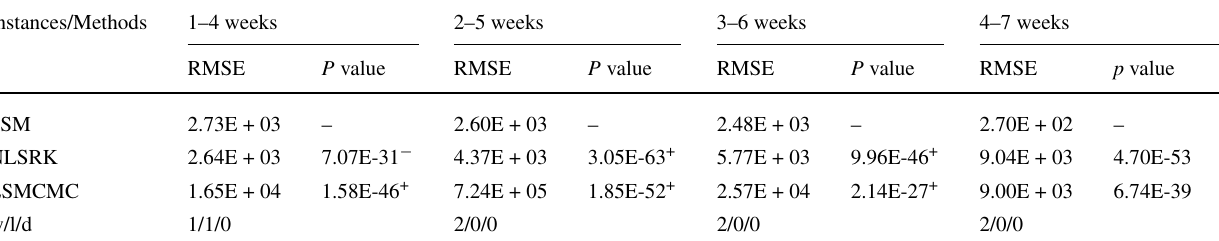
Table 8 Comparison results with numerical methods for simulation days being 21 days ( T 1 (cid:2) 21)